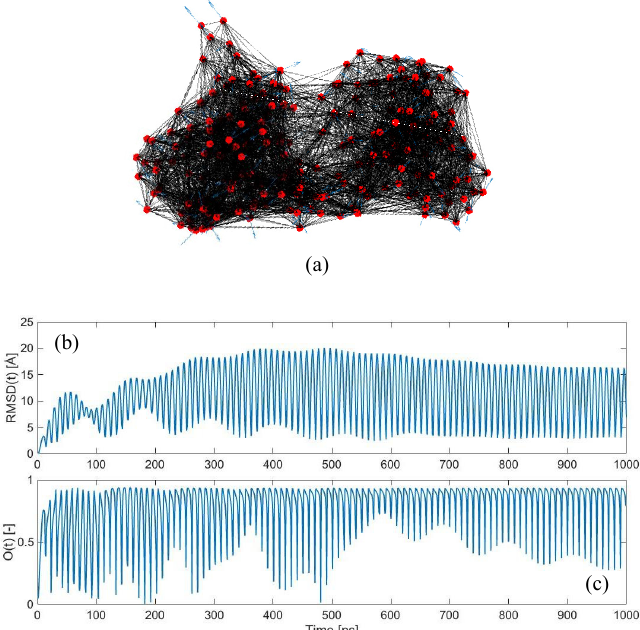
Figure 2. Dynamic force application on LAO-binding protein: ( a ) Elastic network model of the open conformation, with applied external forces with random directions (shown as blue arrows). Exciting frequency of the external perturbation equal to 0.05 THz and damping coefficient ξ equal to 0.01; ( b ) evolution of RMSD in the time-domain; ( c ) overlap values between the conformational change { CC } and the time-dependent displacement vector { u ( t )} at each instant t (maximum overlap 0.94).